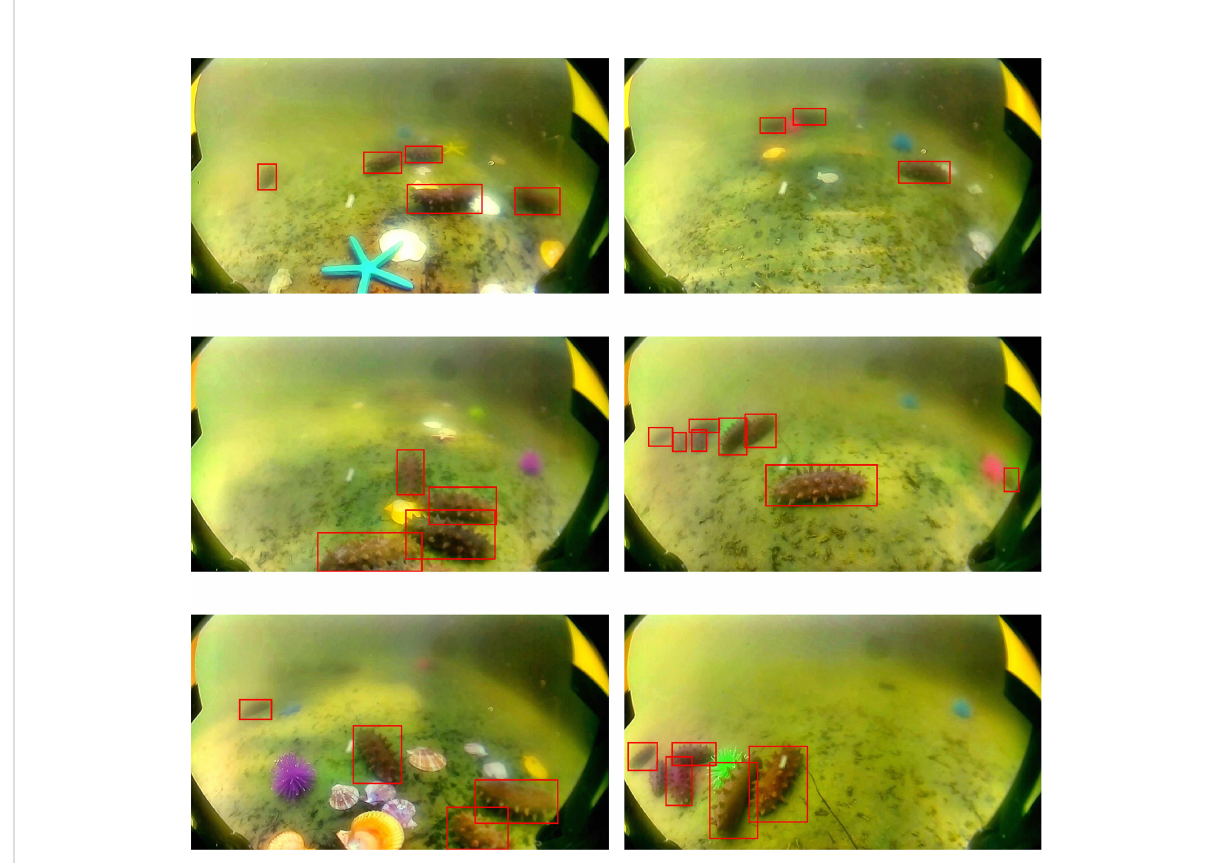
FIGURE 4 Some examples of tracking results produced by our proposed